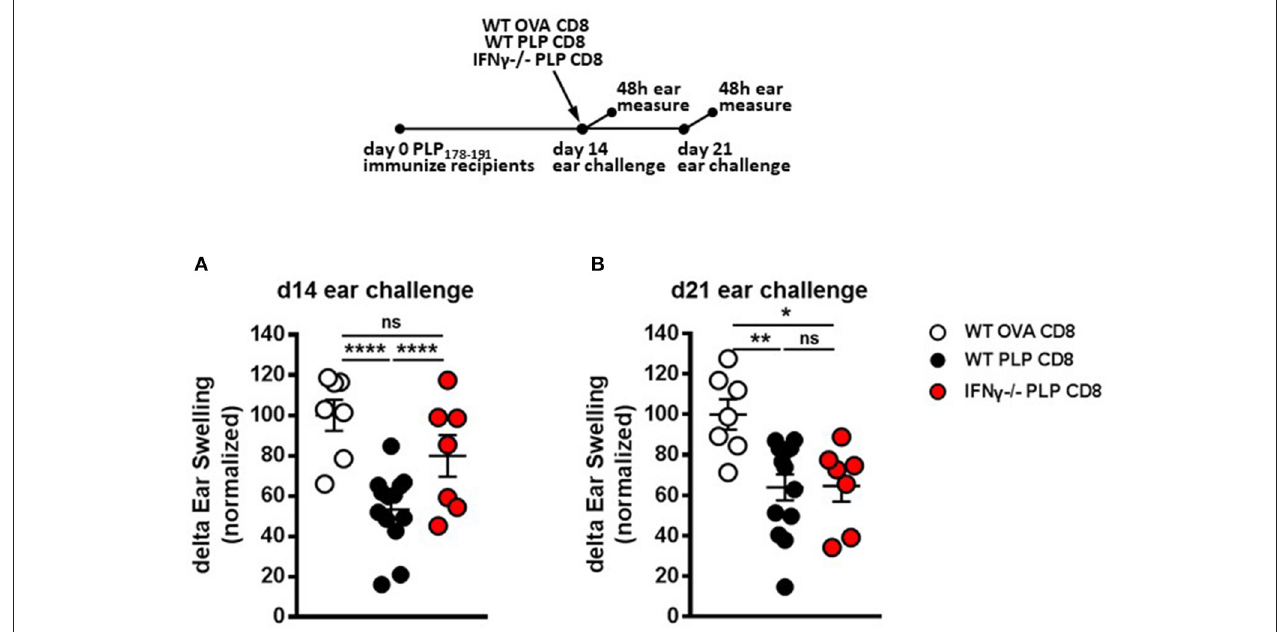
FIGURE 5 | IFN γ production by PLP-specific CD8T cells is required for rapid suppression of PLP-specific CD4T cell responses in vivo but not for long-term maintenance of suppression. (A) Mice were immunized with PLP178-191/CFA on day 0. On day 14, mice were treated with either WT OVA-CD8, WT PLP-CD8, or IFN γ –/– PLP-CD8. On the same day, ears were challenged with PLP178-191 peptide. Ear swelling was measured at 48h. (B) In the identical setup as (A) , ears were challenged at day 21 (7 days post-CD8 treatment) and swelling was measured at 48h. OVA-CD8 n = 7; WT PLP-CD8 n = 13; IFN γ –/– PLP-CD8 n = 7. Data are